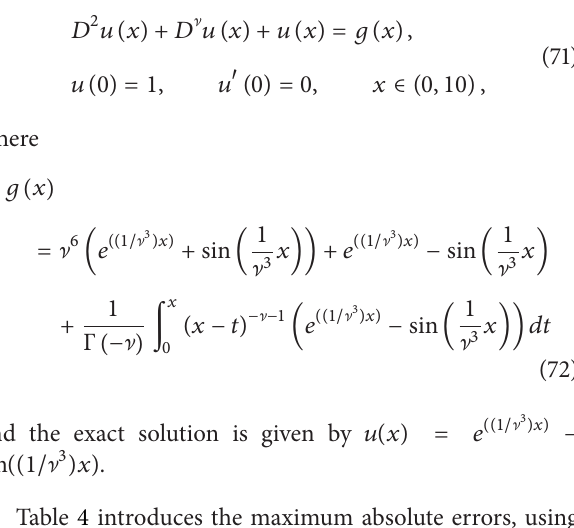
the tau method based on GLOM of fractional derivative, at ] = 1.5 and with different choices of the parameters 𝛼 and 𝑁 . The curves of exact solutions and approximate solutions obtained by the proposed method for 𝛼 = 1 , 𝑁 = 10 , and ] = 1.5, 1.7,